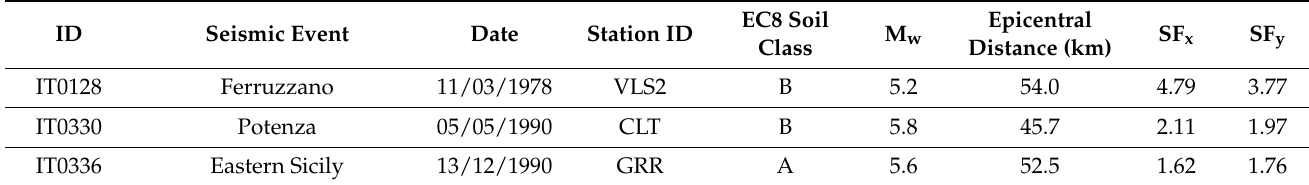
Table 7. Characteristics of the real accelerograms selected for a 475-year return period of the seis- mic action. M w is the moment magnitude and SF is the scale factor applied to obtain spectrum